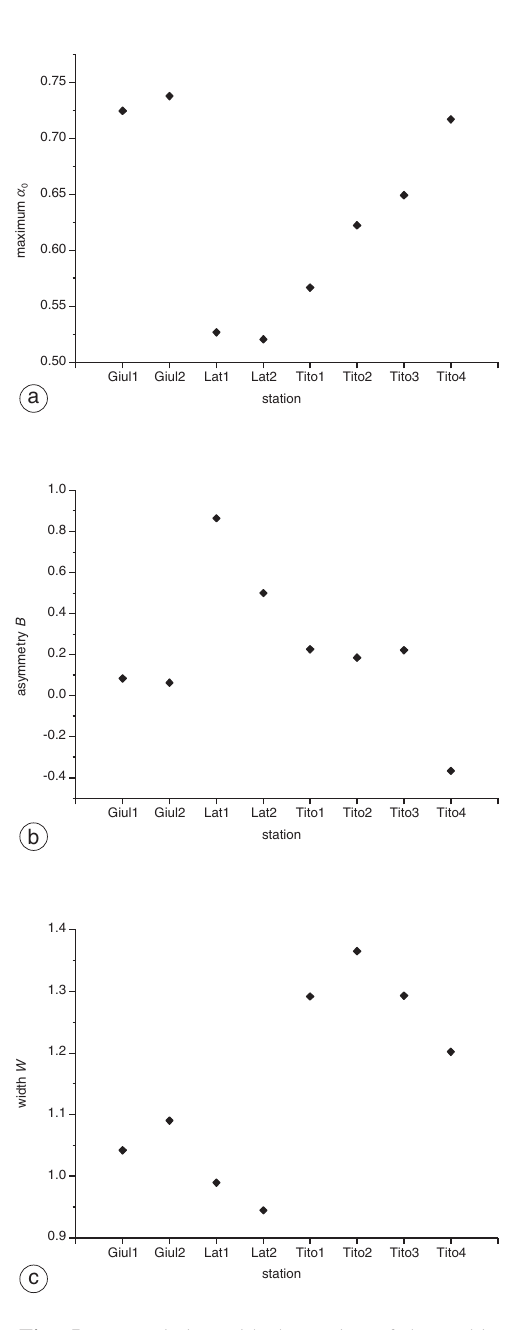
Fig. 5a-c. Variation with the station of the multi- fractal parameters: a) maximum α 0 , b) asymmetry B and (c) width W .